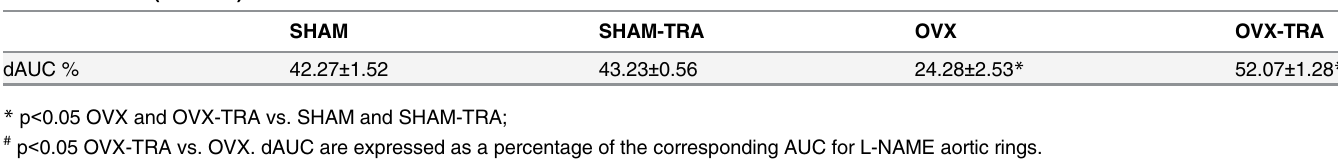
Table 2. Effect of L-NAME (100 μ M) on the concentration — response curve of ACh in aortic rings from SHAM, SHAM-TRA, OVX and OVX-TRA: area under the curve (dAUC